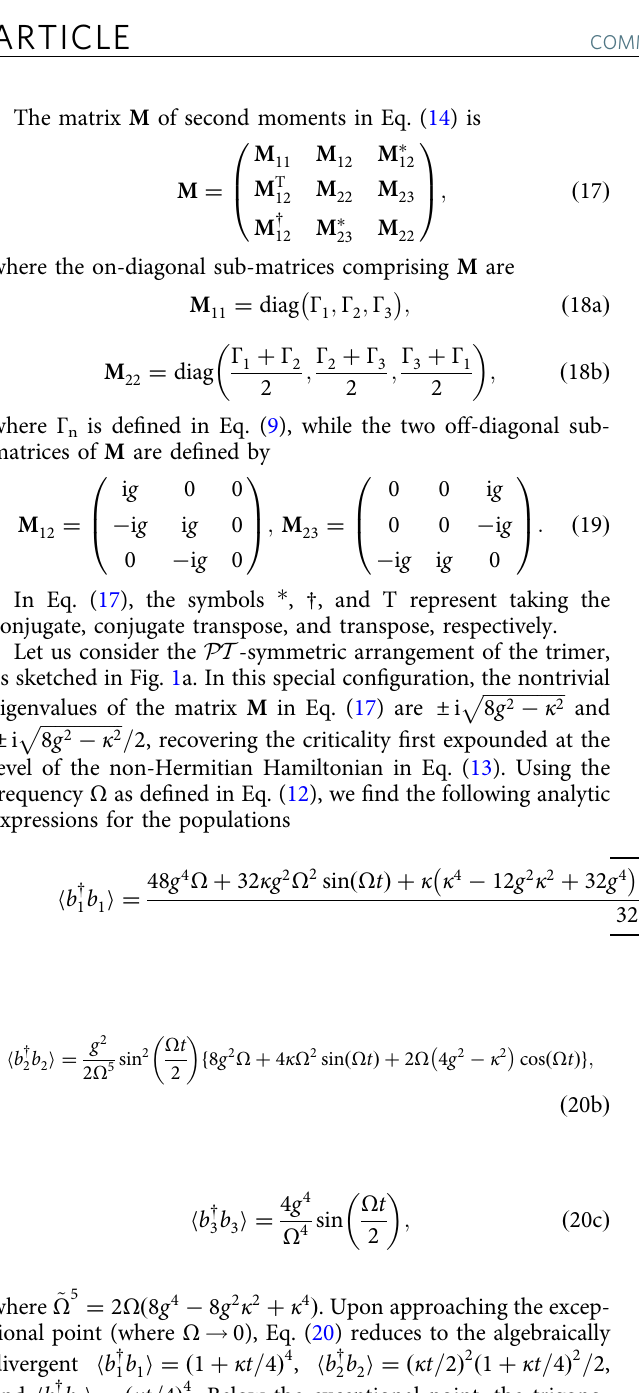
characteristic of the broken PT symmetric phase fi nally